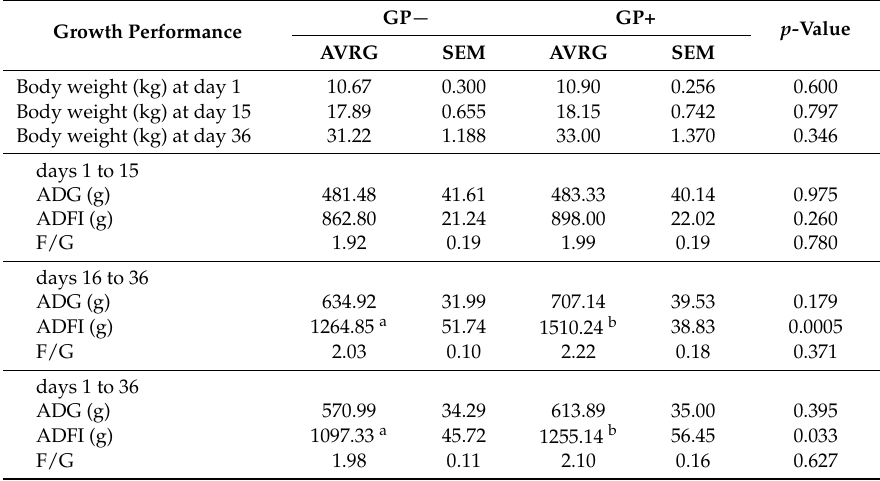
Table 4. Effect of dietary grape pomace diet on the growth performance of piglets.